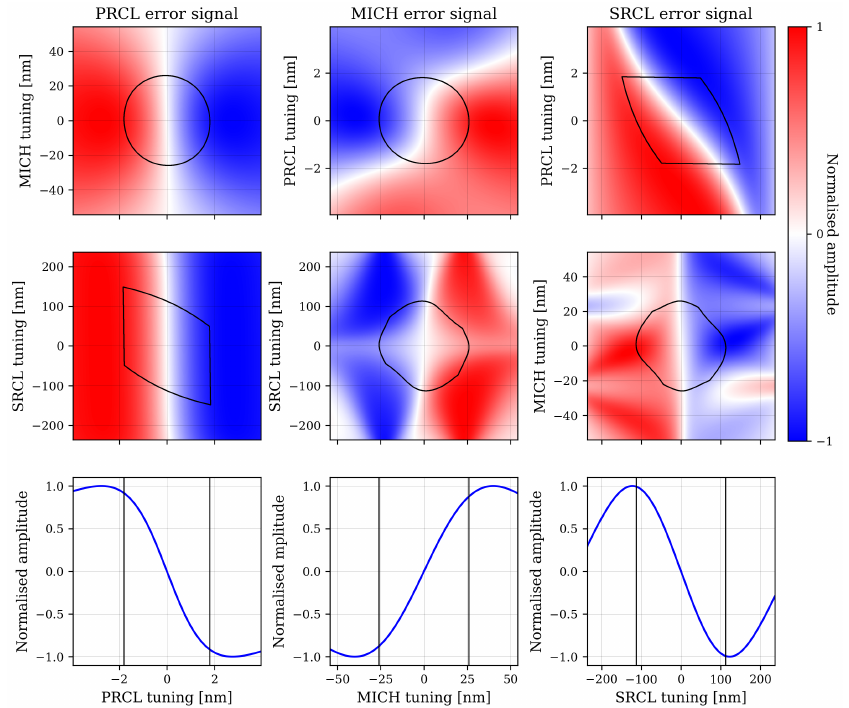
Figure 7. In the first two rows, error signals are plotted against the tuning of pairs of DOFs. At the center of each image is the operating point. Triggering thresholds are exceeded for the points within the black line. In the bottom row, a cross-section of the graphs